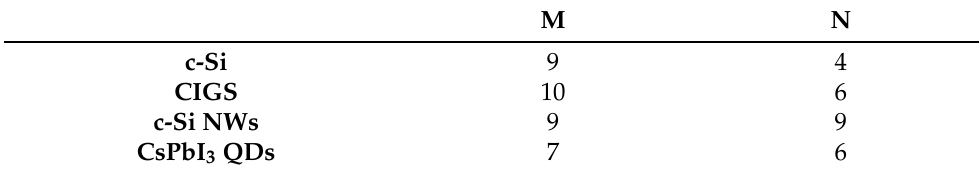
Table 1. Photovoltaic system sizing for the three places.